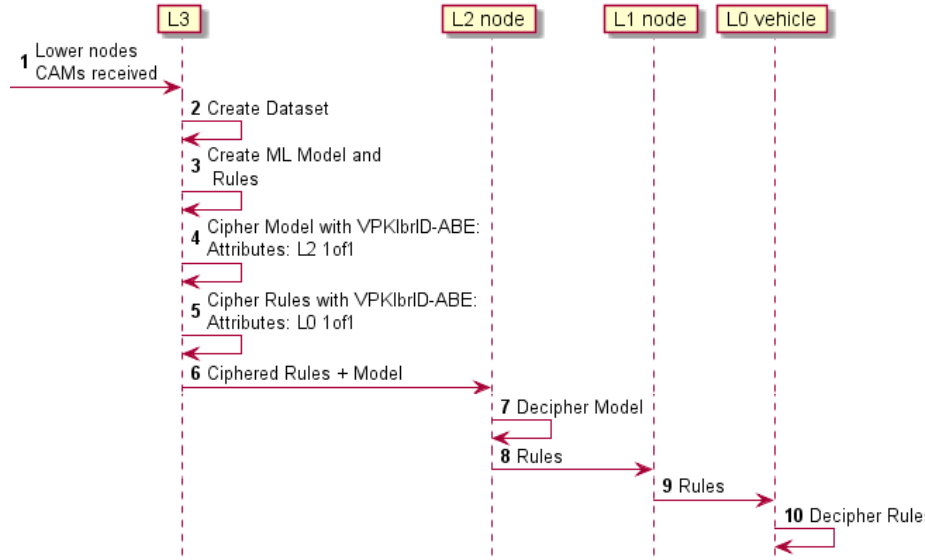
Figure 5. Rules and models communication downstream